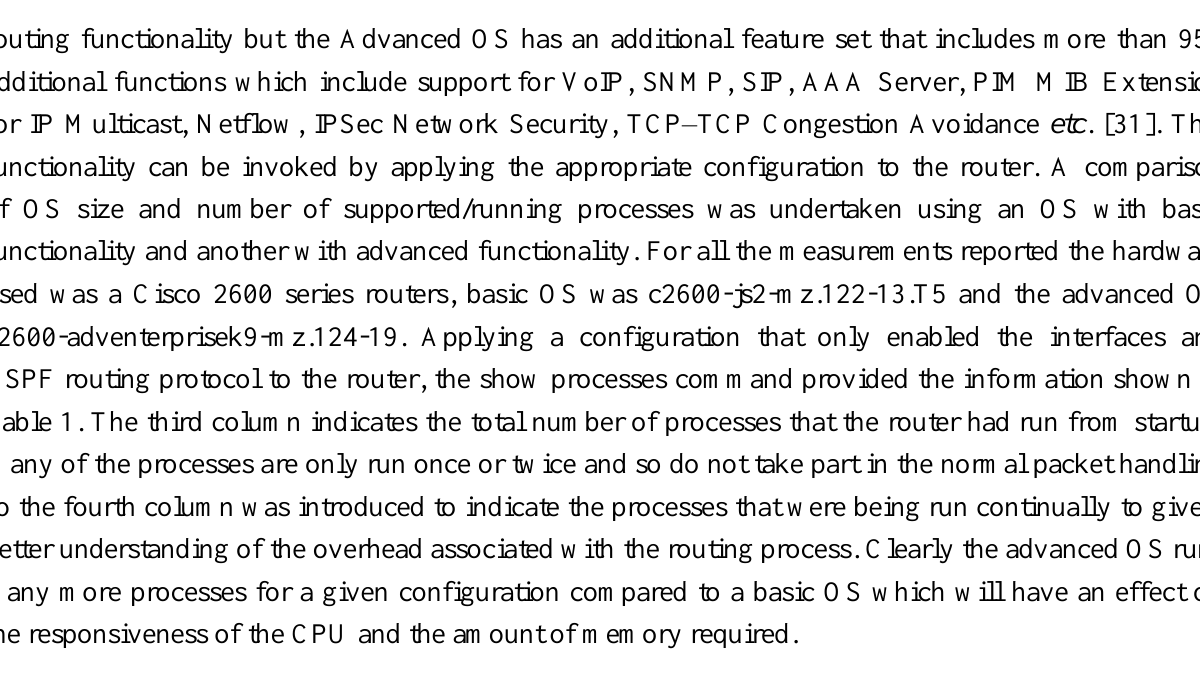
Table 1. Operating System (OS) Comparison.